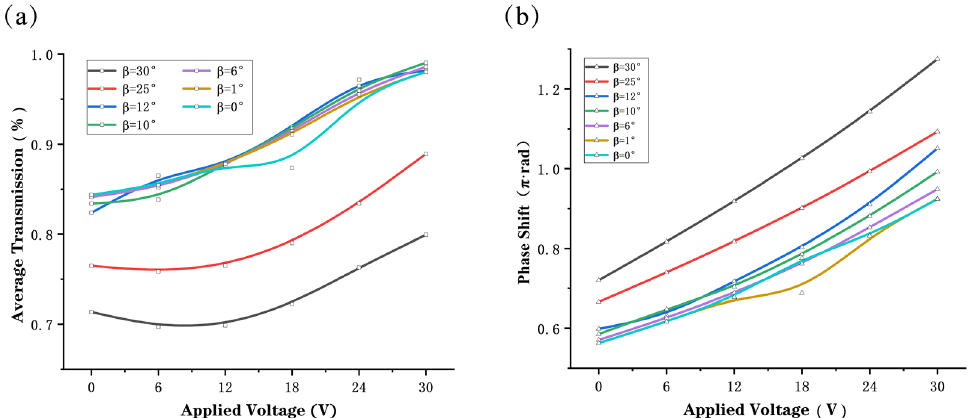
Figure 5. Simulated ( a ) average transmission and ( b ) phase shift of emergent light as a function of applied voltage when a linearly polarized light with polarization direction angle α = π / 4 incident to the metasurface at different angles of incidence β .